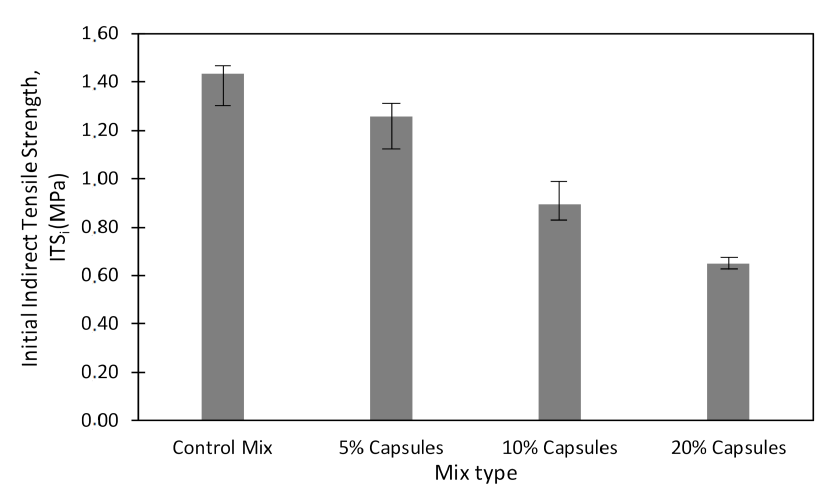
Figure 12. Initial ITS results.